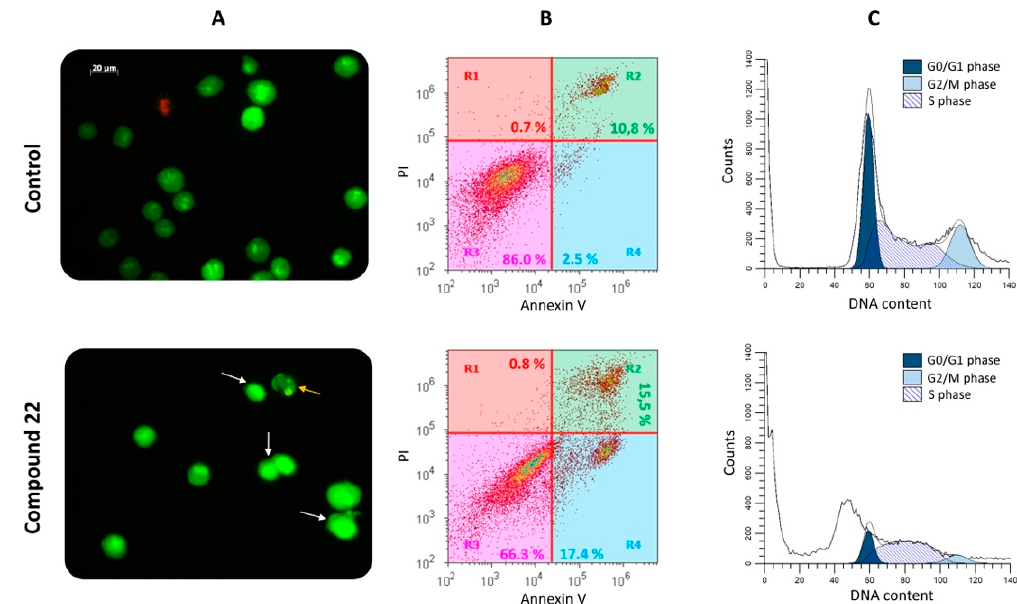
Figure 4. Extended cytotoxicity investigation after treatment of A375 cells with 22 (3.0 µM) for 48 h: ( A ) Fluorescence microscopic images (scale bar 20 µm), AO and PI were used; ( B ) Annexin V-FITC/PI assay. Examples of density plots determined by flow cytometry (Attune ® Cytometric Software vl 1.2.5), R1: necrotic, R2: secondary necrotic / late stage apoptotic, R3: vital, R4: apoptotic; ( C ) Representative examples for cell cycle evaluation via ModFit LT